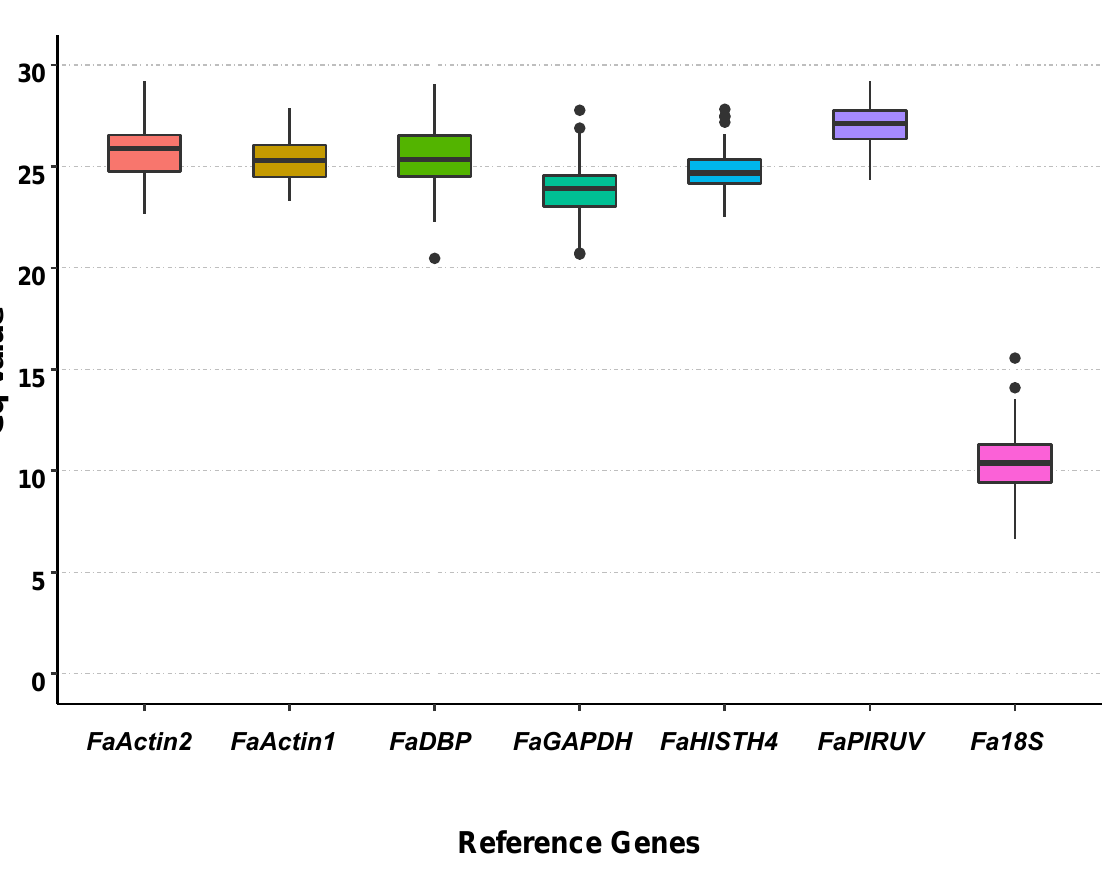
Figure 1. The Cq values of the candidate reference genes in all treated